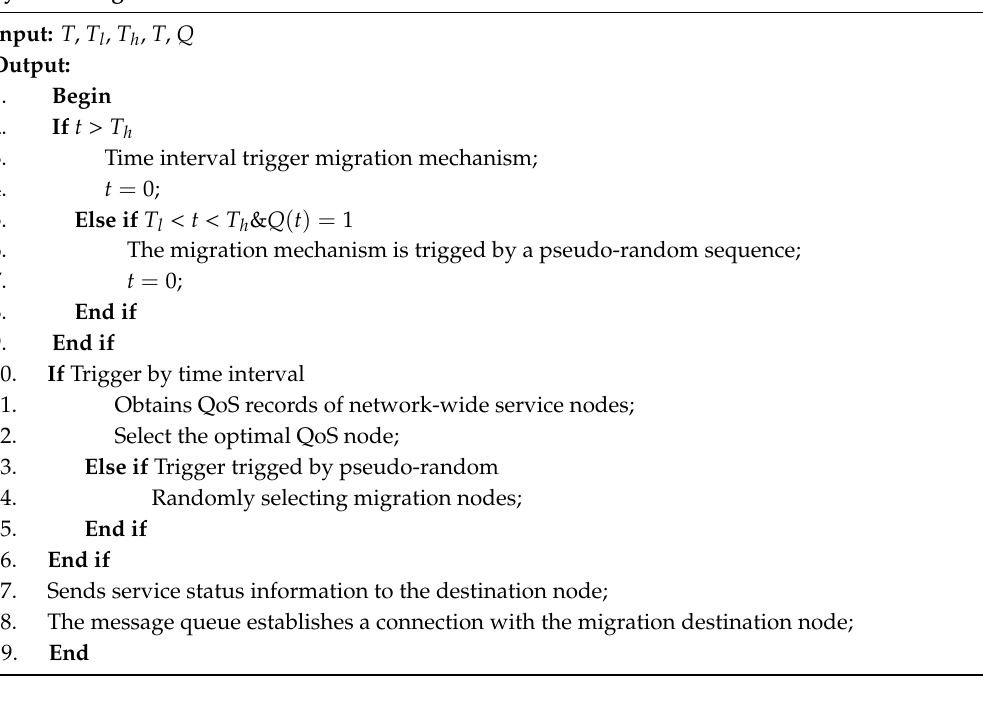
Algorithm 1. The implementation process of the system-wide information management (SWIM) service dynamic migration method.